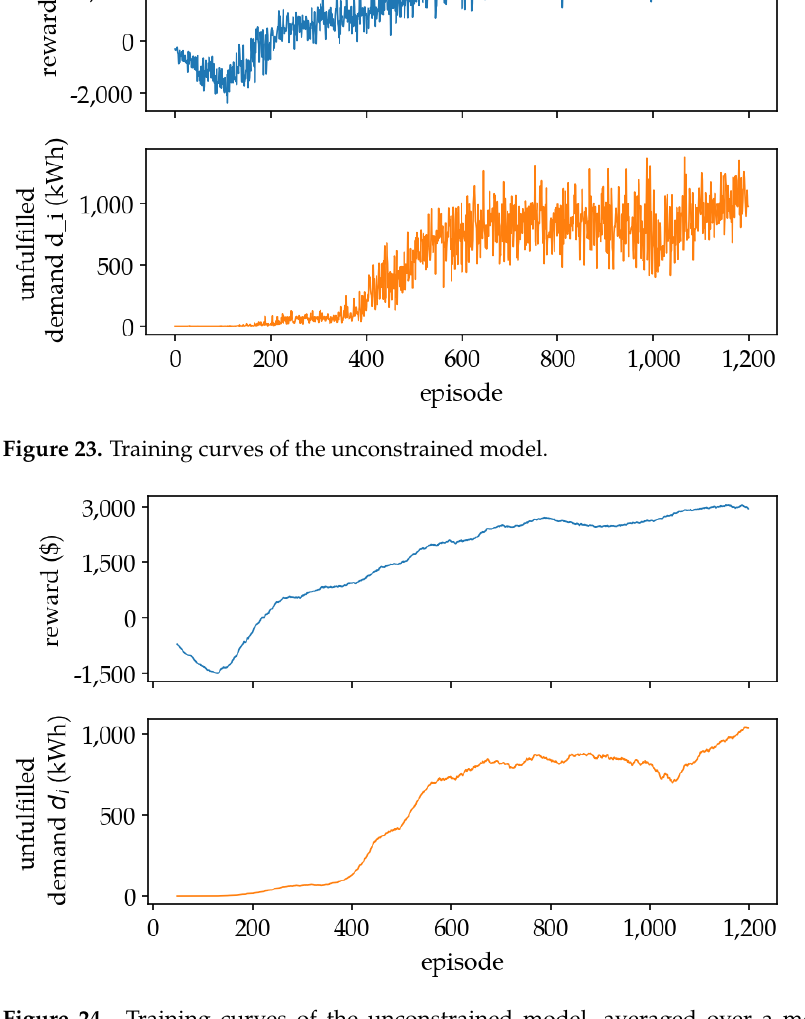
Figure 24. Training curves of the unconstrained model, averaged over a moving window of 50